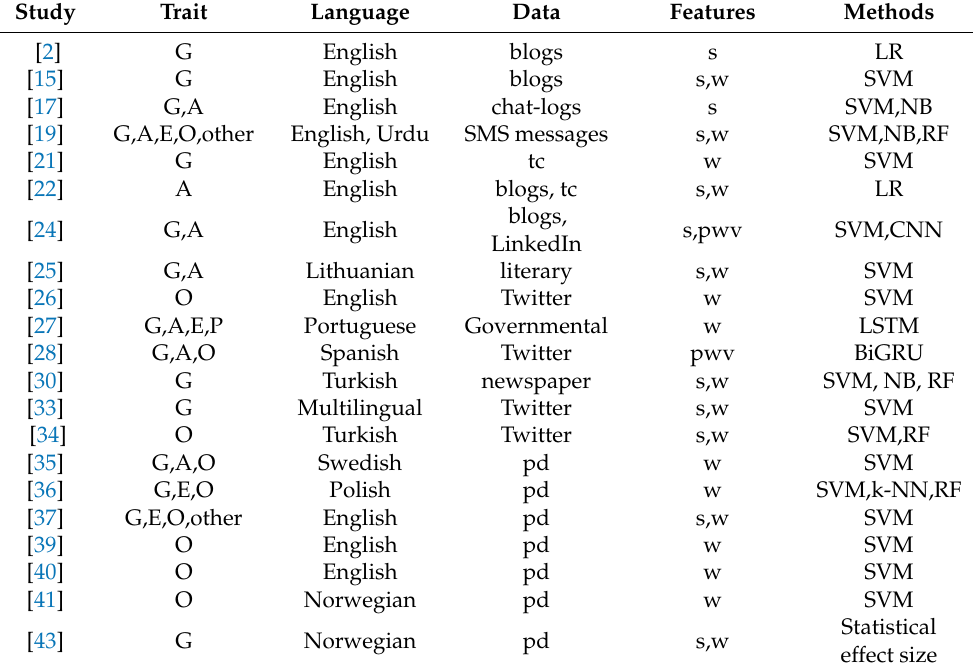
Table 1. Selected Author Profiling studies (G = gender, A = age, O = opinion, party affiliation, ideology, E = Education, P = Profession, np = newspaper articals, tc = telephone conversations, pd = parliament debates, s = stylometry, stylistic, character n-gram, linguistic features, w = BoW, TF-IDF, pwd = pretrained word